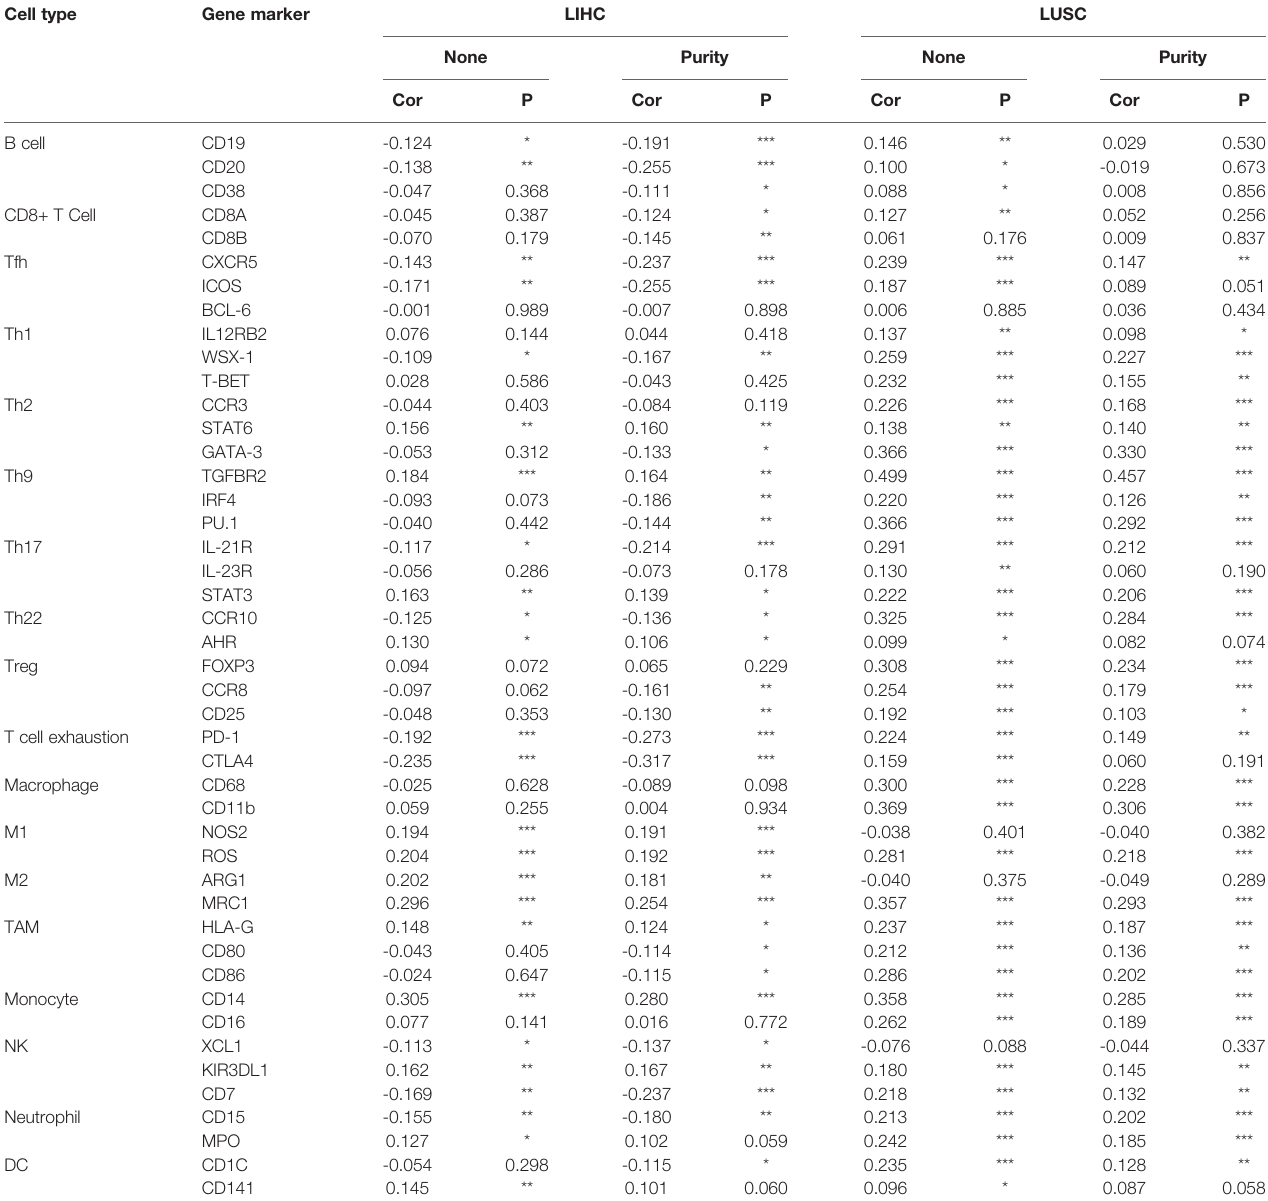
TABLE 2 | The correlation between PINK1 expression and immune cells related gene markers. (TIMER database). Cell type Gene